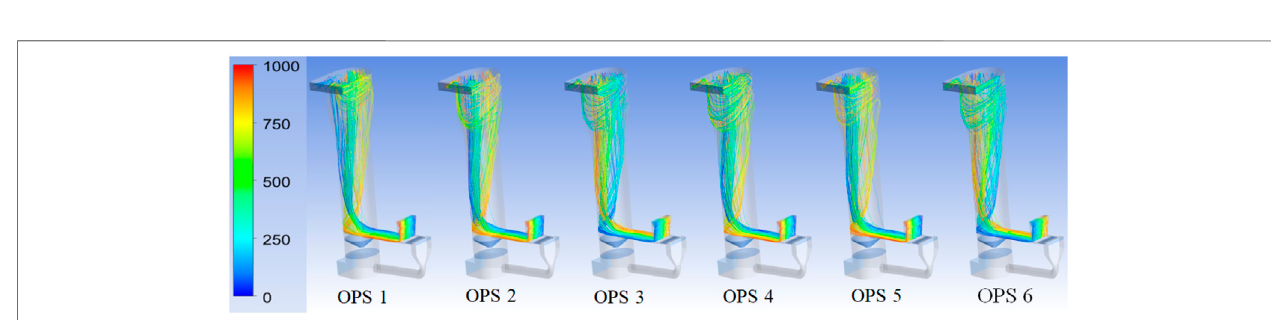
FIGURE 9 | Particle trajectory of the tobacco